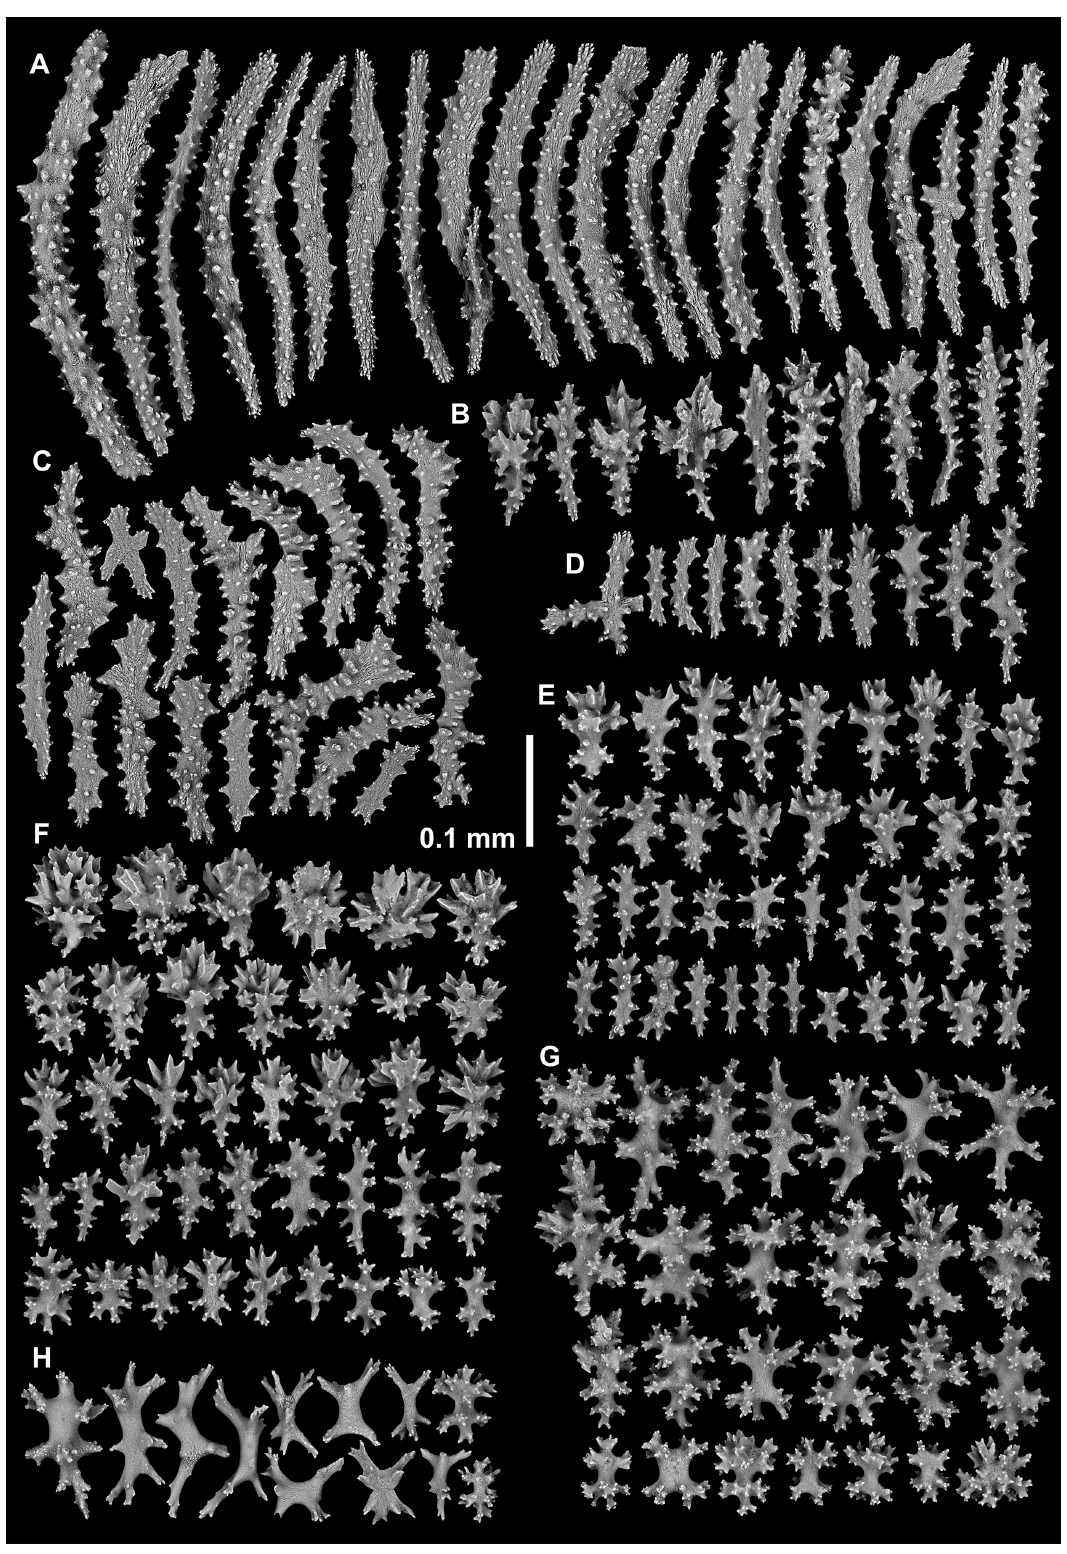
Fig. 27. Kotatea teorowai gen. et sp. nov., holotype (NIWA 27358), SEMs of sclerites. A . Collaret and points. B . Distal points. C . Tentacles. D . Polyp neck. E . Polyp mound. F . Lobe surface. G . Base surface. H . Lobe and base